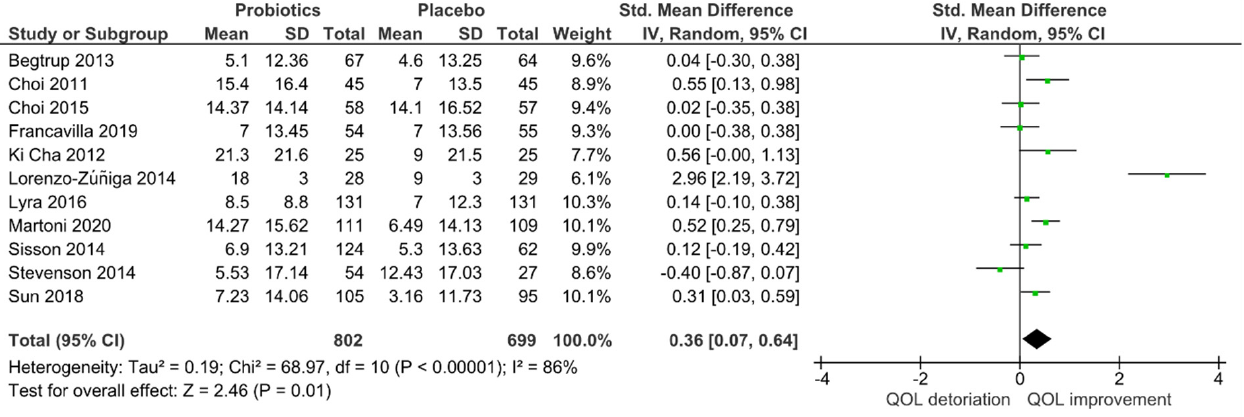
Figure 3. Quantitative analysis for QoL of randomized controlled trials in IBS receiving either probiotics or placebo treat- ment.